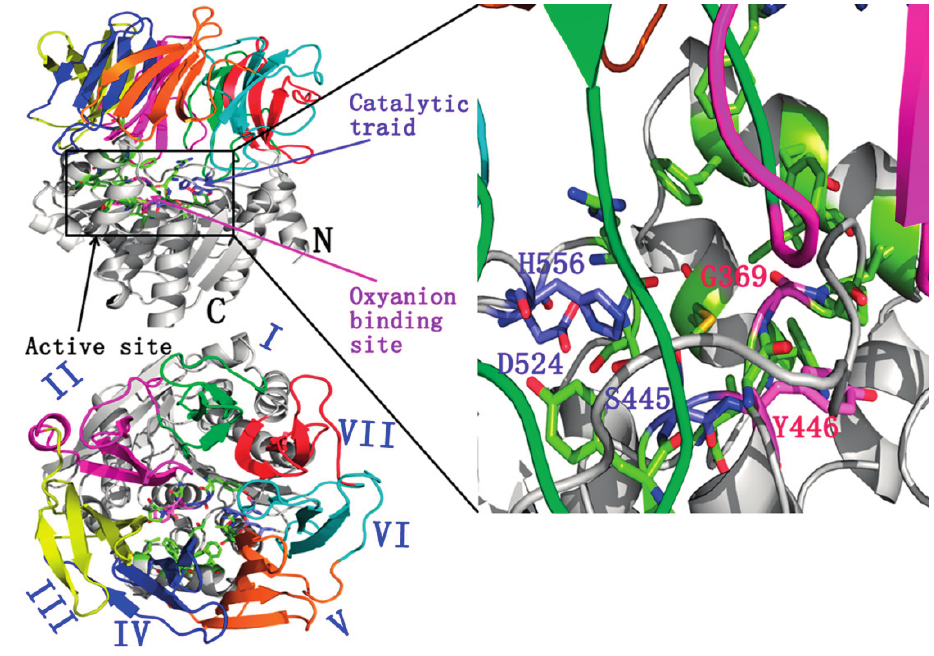
Figure 1. The active triad of acylpeptide hydrolases (APH): Ser445, His556, and Asp524. Ser445, Gly369 and Tyr446 function as oxyanion hole. PDB Id